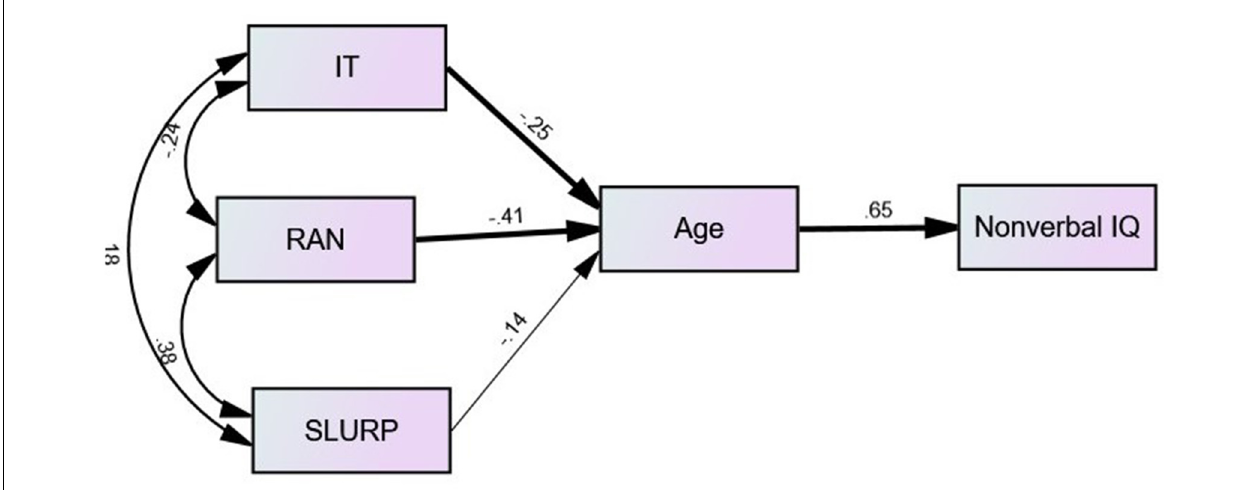
FIGURE 6 | Path-diagram of age mediating the relationships between visual processing speed and nonverbal IQ. IT, Inspection Time; RAN, Rapid Automatic Naming; SLURP, visuomotor performance task; Nonverbal IQ, Intelligence Quotient score on Raven’s Coloured Progressive Matrices task. Note . Significant paths are in